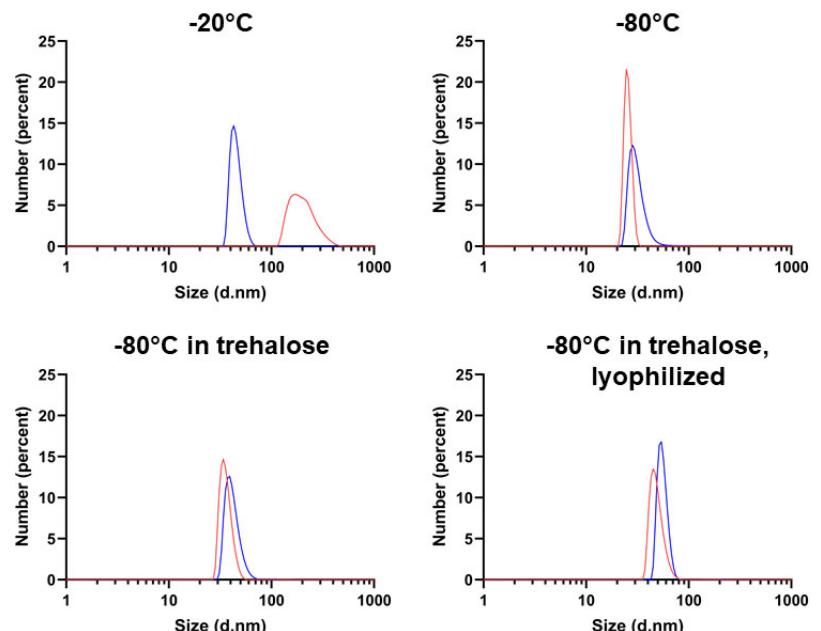
Figure 5. DLS of the 20,000 × g supernatants of vault samples incubated for 7 days and otherwise as indicated in the respective panels. Results are presented as number-weighted particle size distribution. − 20 °C: size 204.8 ± 17.9 (mean ± std. dev.) nm, PDI: 0.332; − 80 °C: size 94.00 ± 9.09 nm, PDI 0.007; − 80 °C plus trehalose: size 120.30 ± 11.89, PDI 0.044; − 80 °C plus trehalose, lyophilized and reconstituted: size 148.20 ± 19.24, PDI 0.145. Result quality: good. In each panel, two replicates of the measurement are shown. The relevant intensity and autocorrelation plots are presented in Figure S4.